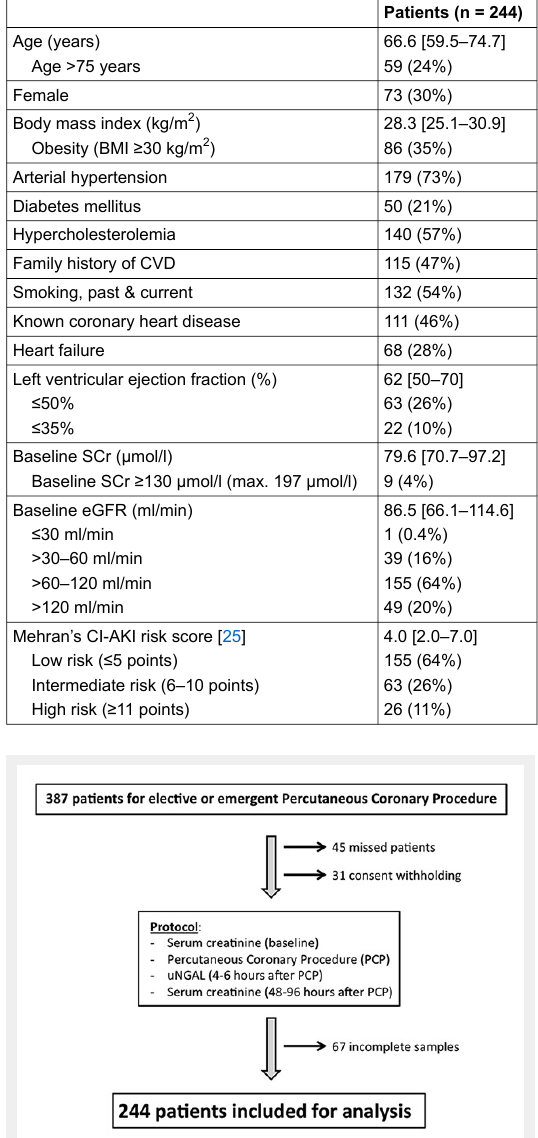
Table 1 : Baseline clinical and biological characteristics in patients undergoing PCP. Data are presented as median [interquartile range] or number of patients (%). BMI = body mass index; CI-AKI = contrast-induced acute kidney injury; CVD = cardiovascular disease; eGFR = estimated glomerular filtration rate; SCr = serum creatinine.